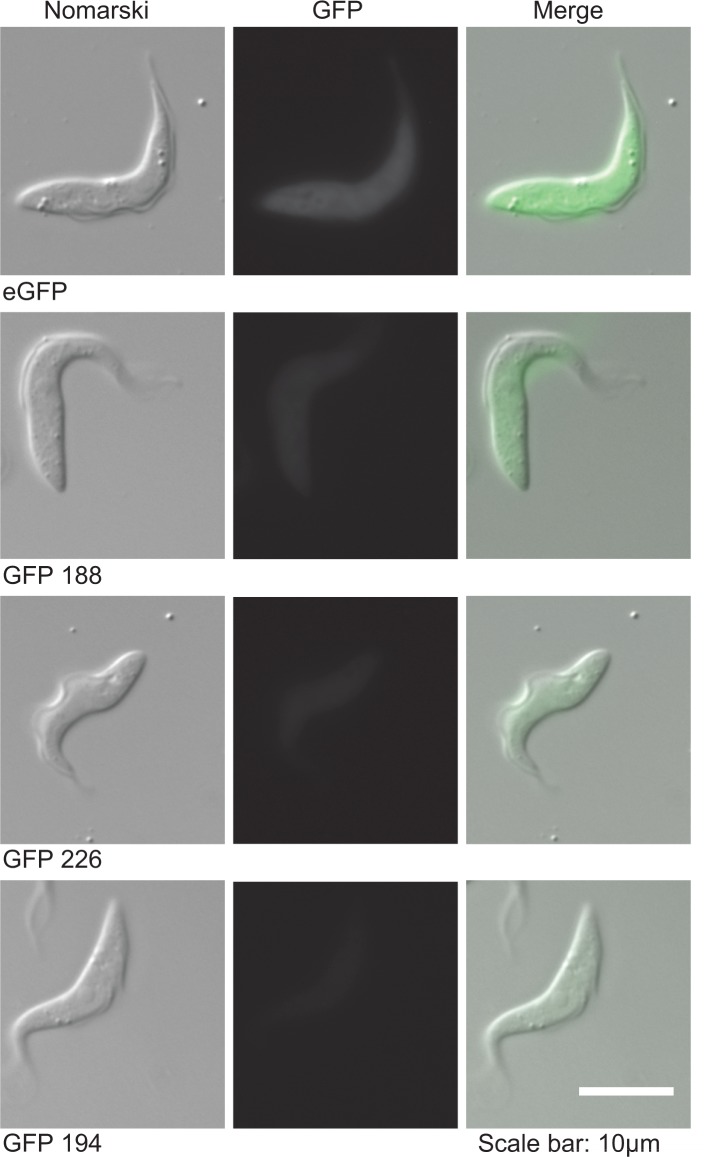
Differences in expression levels of four GFP transgenes with different codon usage.Live cells were imaged and a constant exposure time of 1 s was used. The sequences of the GFP ORFs is in Supplementary file 3.